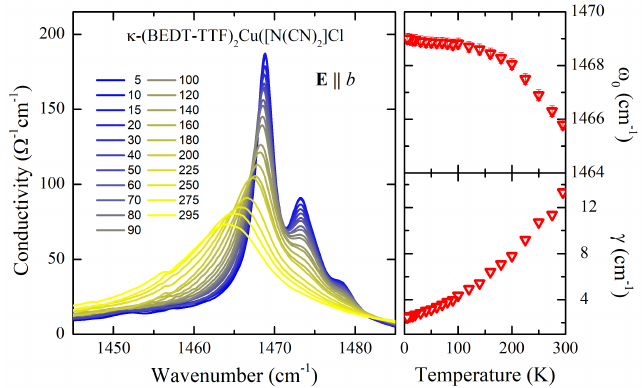
Figure 7. ( Left ) Temperature evolution of the intramolecular vibration ν 27 in sample S2 of κ -Cl. ( Right ) Temperature dependence of the resonance frequency and damping obtained by Fano function fit of the mode.